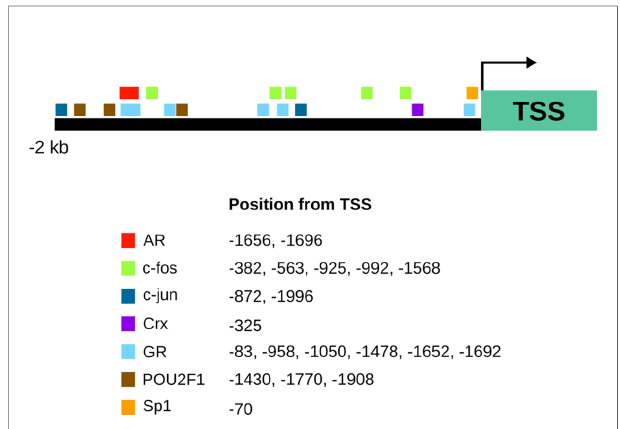
FIGURE 1 | A map of candidates for transcriptional regulation of Trhde expression predicted by bioinformatic analysis. Transcription factor binding sites were identi fi ed 2 kb upstream of the most upstream of the 3 predicted transcriptional start sites (TSSR99301) of the mouse with PROMO (Messeguer et al., 2002; Farre, 2003). This site is conserved in rats. AR, androgen receptor; Crx, Cone-rod homeobox protein; GR, glucocorticoid receptor; NF-kappaB, nuclear factor kappa-light-chain-enhancer of activated B cells; POU2F1, POU domain, class 2, transcription factor 1; Sp1, speci fi city protein